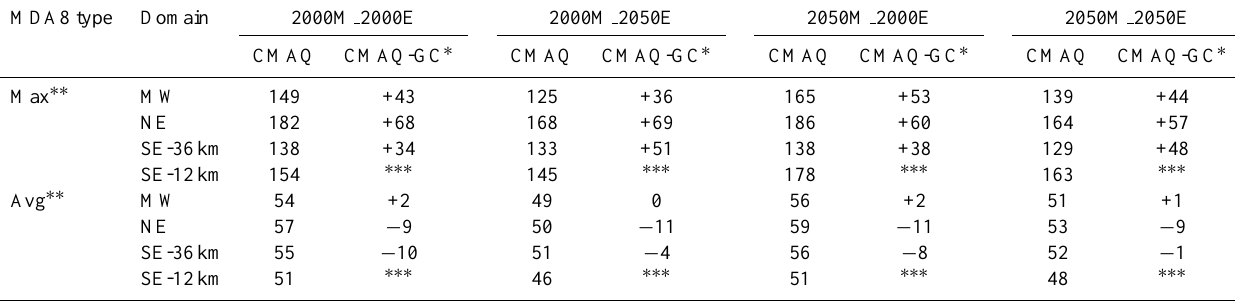
Table 7. Summary of MDA8 ozone (in ppbv) from CMAQ outputs and the concentration differences between CMAQ and GEOS-Chem for the present and future